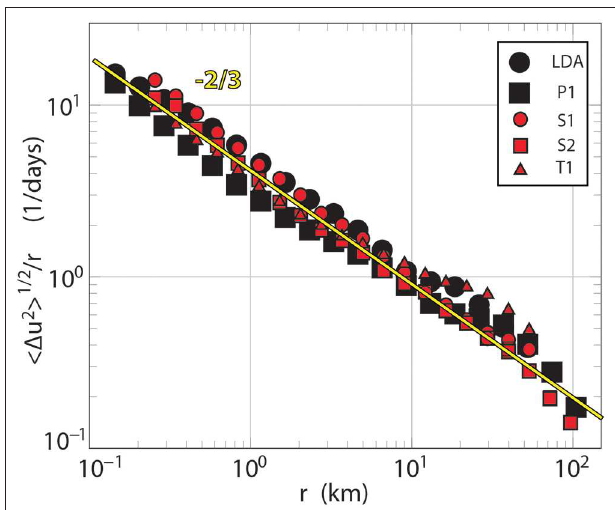
FIGURE 9 | The scale dependent dispersion rate for five large drifter deployments in the Northern Gulf of Mexico. LDA and P1 (black) were part of LASER in winter 2016; S1, S2, and T1 were in GLAD (summer 2012). The yellow line has a slope of −